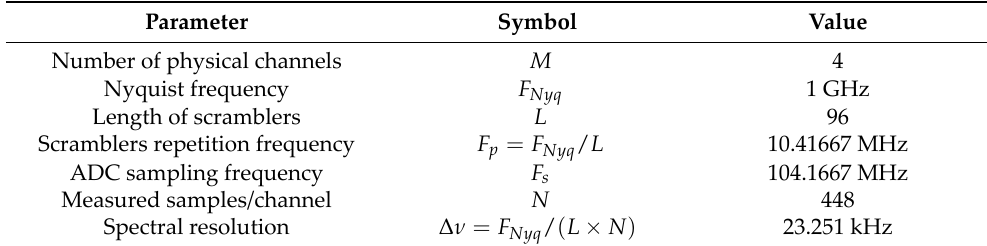
Figure 7. Block diagram of our compressed sampling testbed. Table 1. Main parameters of the experimental testbed used to evaluate the proposed algorithm.